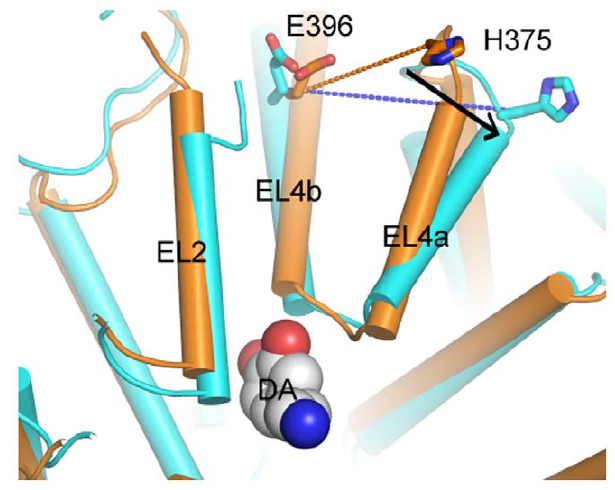
Figure 7. The endogenous Zn 2 + binding site. Extracellular portions of DAT containing the endogenous Zn 2 + binding site. S1-DAT (orange) and the inward-facing DAT (cyan) are aligned with RMSDTT using the whole structure and rendered in cartoon. The sidechains of Zn 2 + binding residues H375 EL4a and E396 EL4b are rendered in sticks. In S1- DAT, the average C a distance between H375 EL4a and E396 El4b is 13 A˚ (orange dashed line). The distance increases to 15 A˚ in the inward- facing conformation (blue dashed line). loop segments that are captured in the types of conceptual models referring to the molecule undergoing transitions between states, e.g., from outward-open/facing to inward-open/facing states of the transporter.